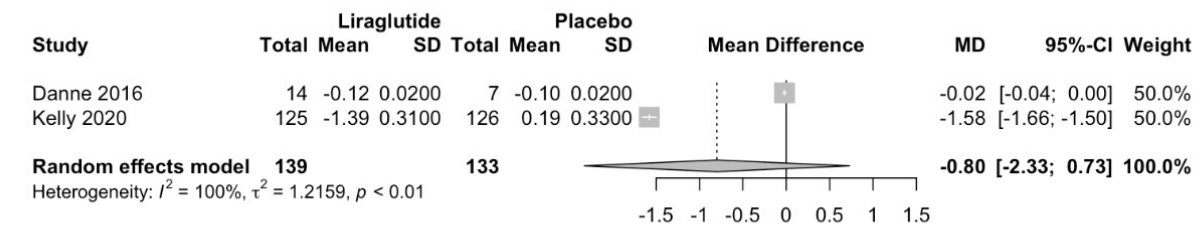
Figure 3. Effect of Liraglutide on BMI [30,31].